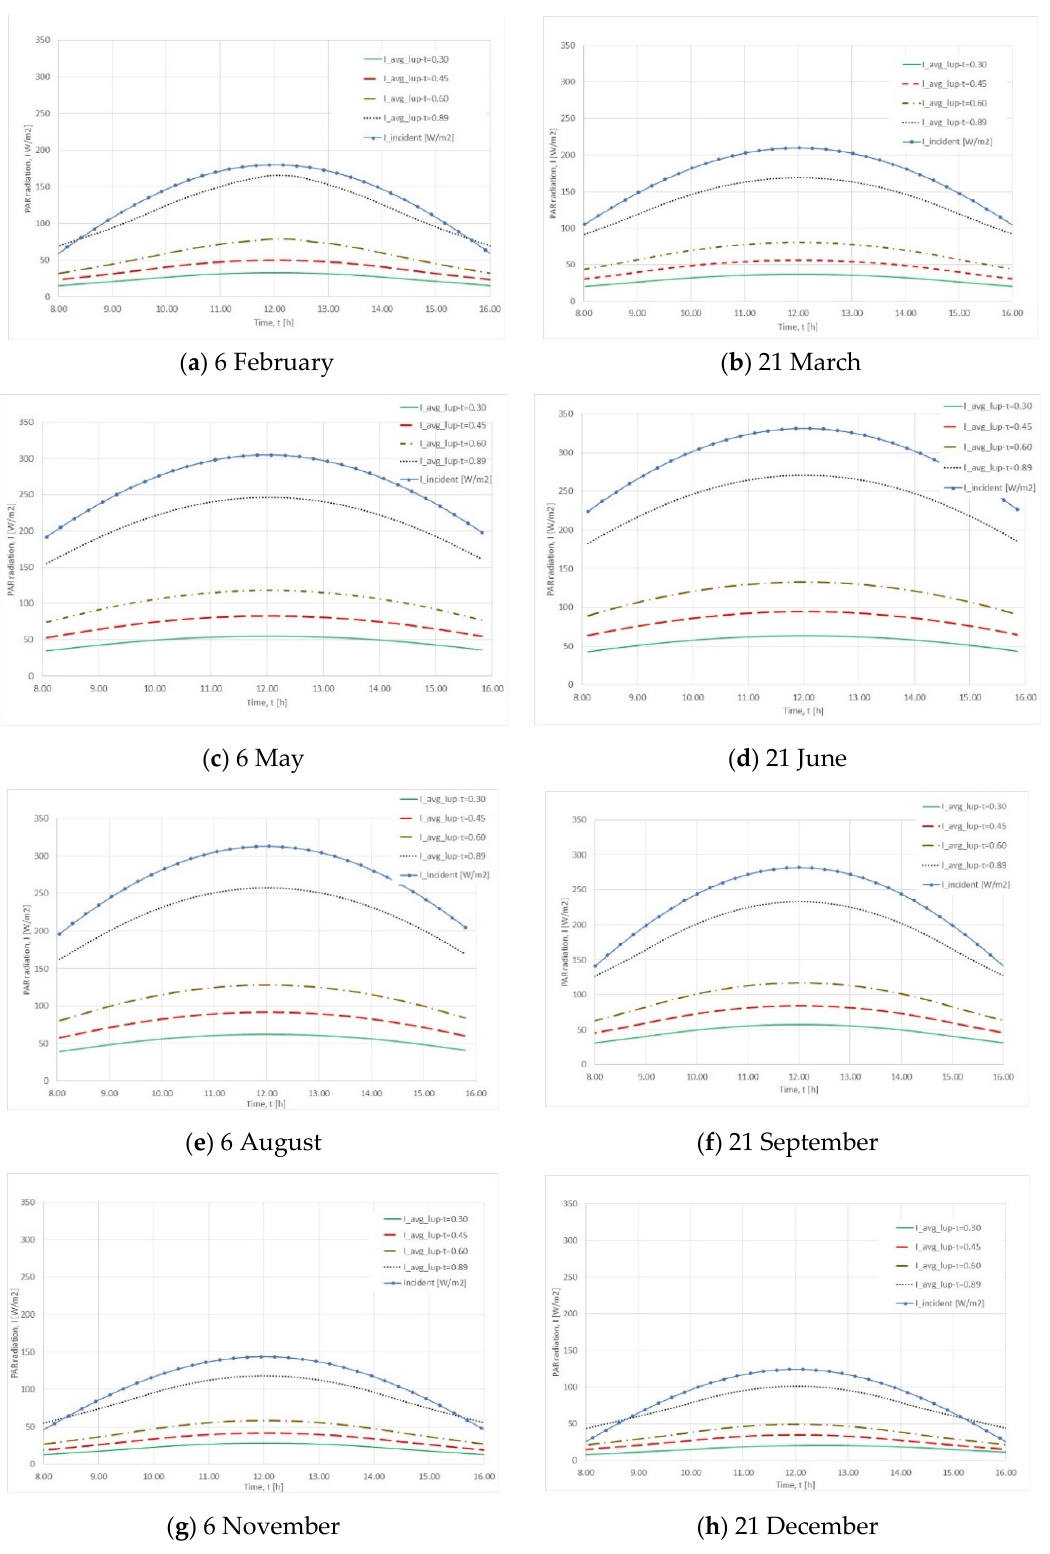
Figure 7. Average PAR at plant level during the solar day for 8 indicative days of the year. (i) τ n,PAR = 30% (green line continuous), (ii) τ n,PAR = 45% (red dashed line), (iii) τ n,PAR = 60% (brown dot-dashed line), (iv) τ n,PAR = 89%—bare cover (black dotted line), and (v) PAR incident to horizontal surface in open field (blue continuous line with blue circles).